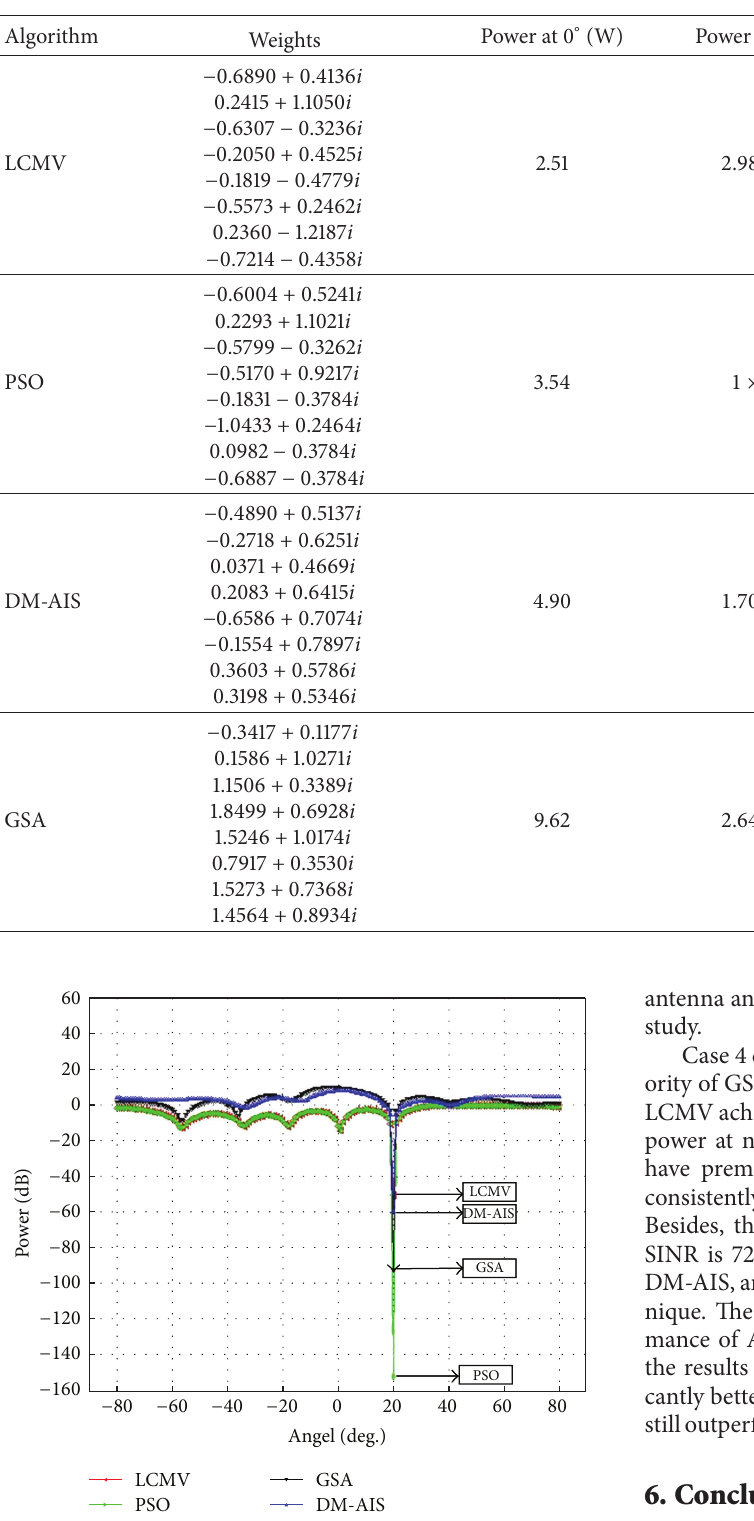
Table 5: Comparison of weight vectors, power values, and SINR calculation for conventional LCMV, PSO-LCMV, DM-AIS-LCMV, and